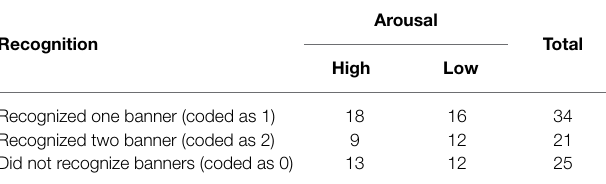
TABLE 4 | Summary table of recognized banners with high and low arousal.